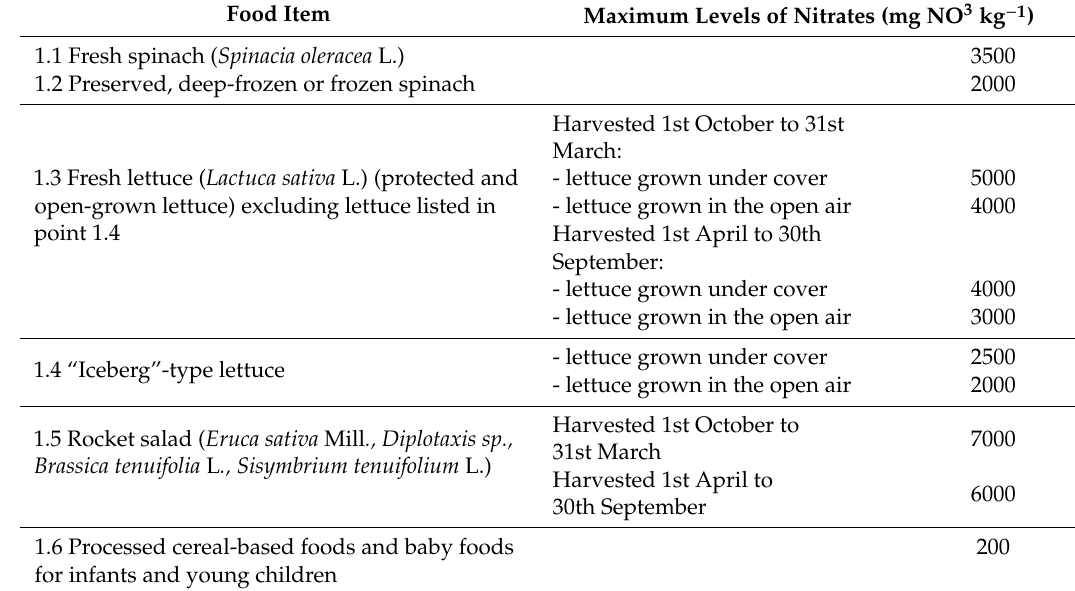
Table A1. Maximum levels of nitrates admitted in vegetables in the European Union. Food